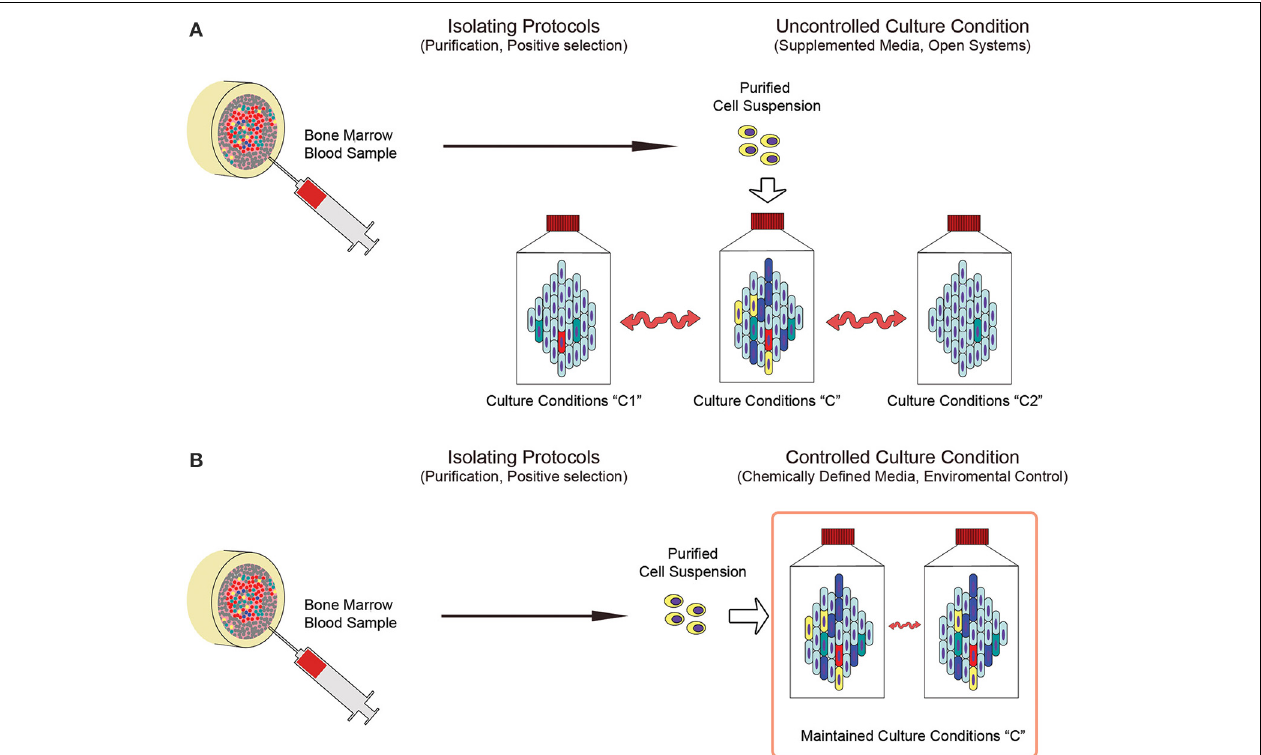
FIGURE 3 | Deterministic and stochastic approaches in the production of MSCs. (A) Applying predetermined purified cell populations could drastically reduce the variability of starting material (indicated as “Purified Cell Suspension”)enablingthedesignofdefinedcultureconditionsthatarespecific totheuniqueculture-initiatingcellpopulationofinterest.Nonetheless,applying uncontrolledculturesystemsdonotpreventfromtheheterogeneityintroduced